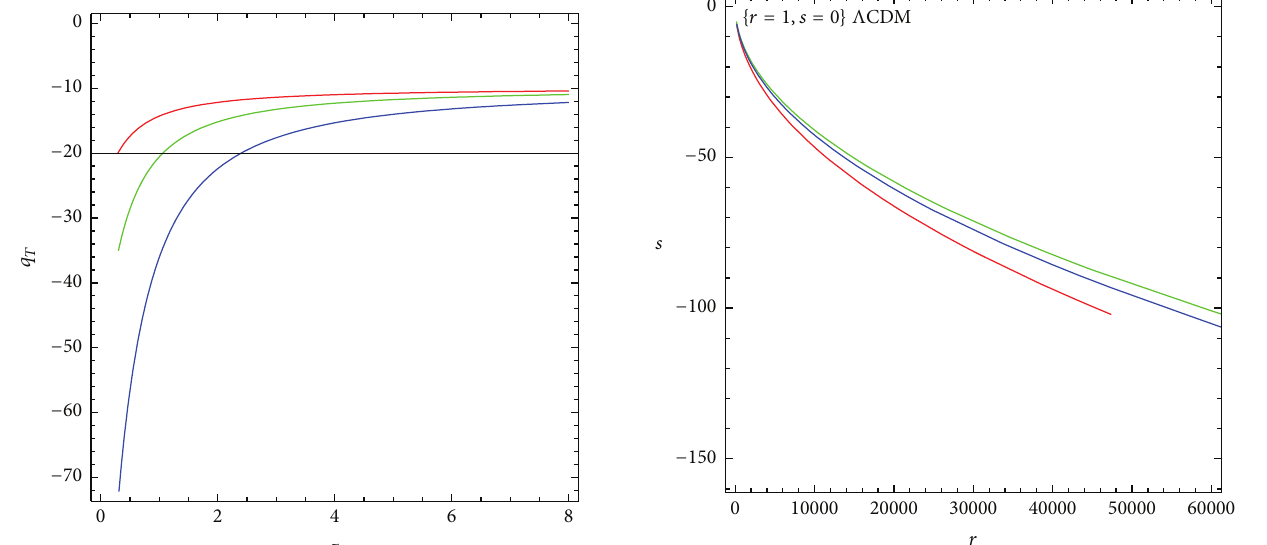
Figure 8: Deceleration parameter 𝑞 𝑇 for the Bengochea and Ferraro model.